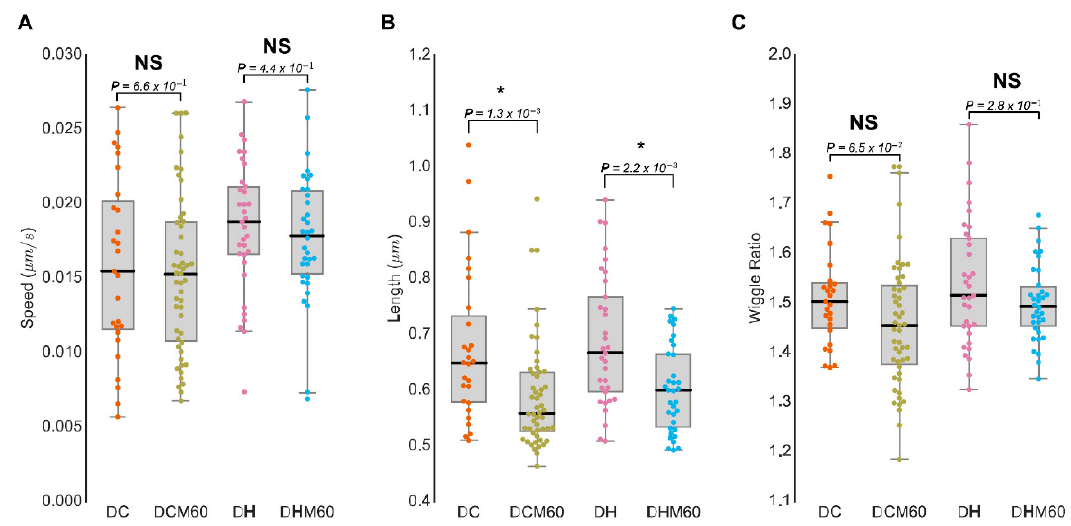
Figure 5. Mitochondrial network activity in live cells with and without MDIVI-1 treatment. The living cell mitochondrial video was captured using high resolution confocal laser scanning microscopy LSM880 and Airyscan-processed images were analyzed using Mytoe to measure speed ( A ), cell length ( B ), and wiggle ratio ( C ) after 60 min of 10 µM MDIVI-1 treatment. Box plots present the cell average of speed, length, and wiggle ratio. * p < 0.05 values indicate significance from the Mann–Whitney test in all three panels. Table 2. D -10 , D 0 , D 1 , D 2 , and D 10 of the mitochondrial network of SCLC cells in control and HGF-stimulated groups before and after MDIVI-1 treatment.